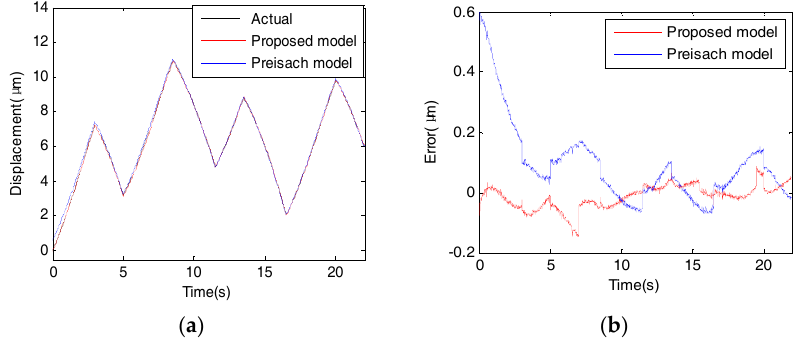
Figure 18. The responses triangular excitation with a low rate. ( a ) The output displacement curves; ( b ) error curves.